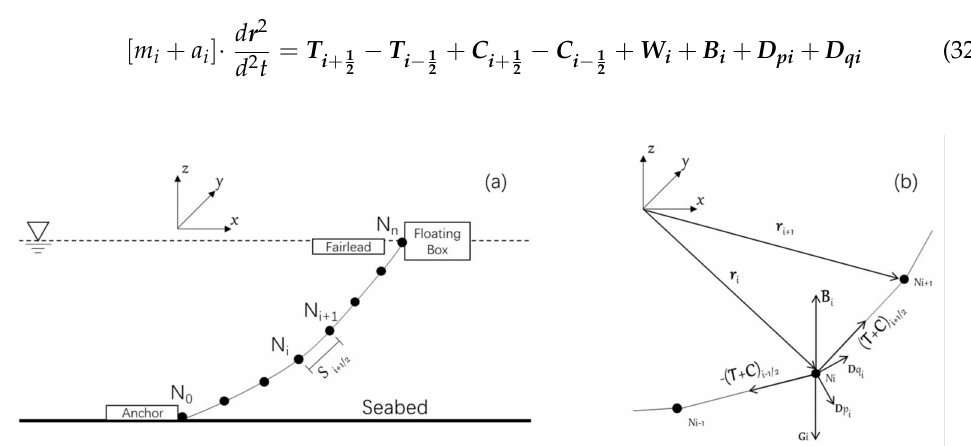
Figure 1. Illustration of the lumped-mass approach: ( a ) mooring line discretization; ( b ) internal and external forces on a